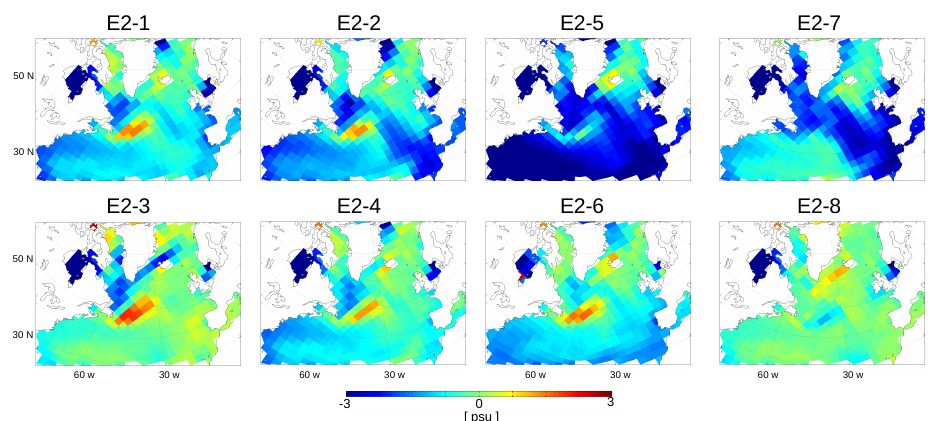
Fig. 3. Anomalies of the sea-surface salinity in E2-1–E2-8 compared to Target 2.